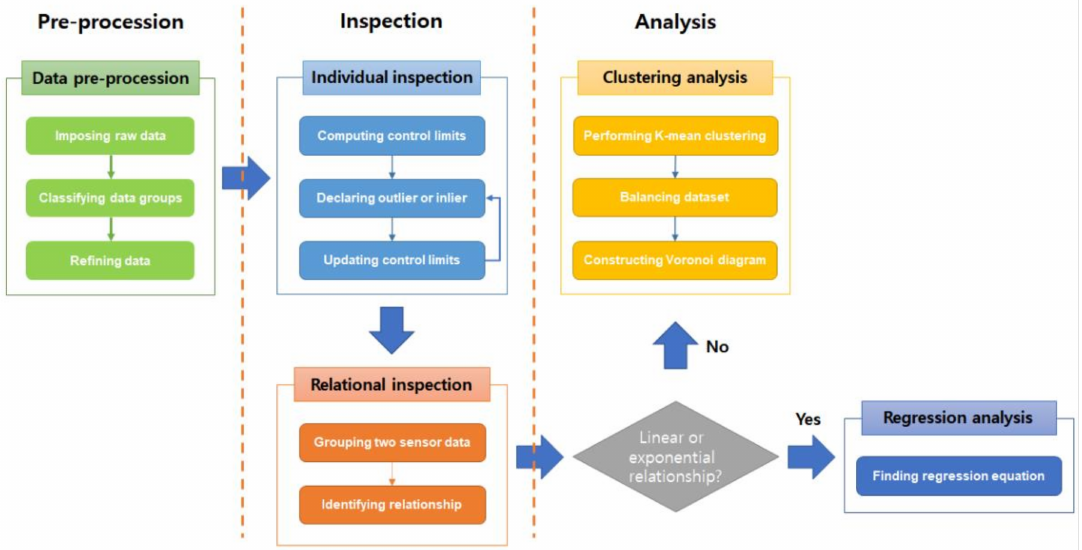
Figure 1. Flow chart describing our proposed algorithm. The algorithm consisted of three steps: data preprocessing, individual and relational inspection, and clustering and regression